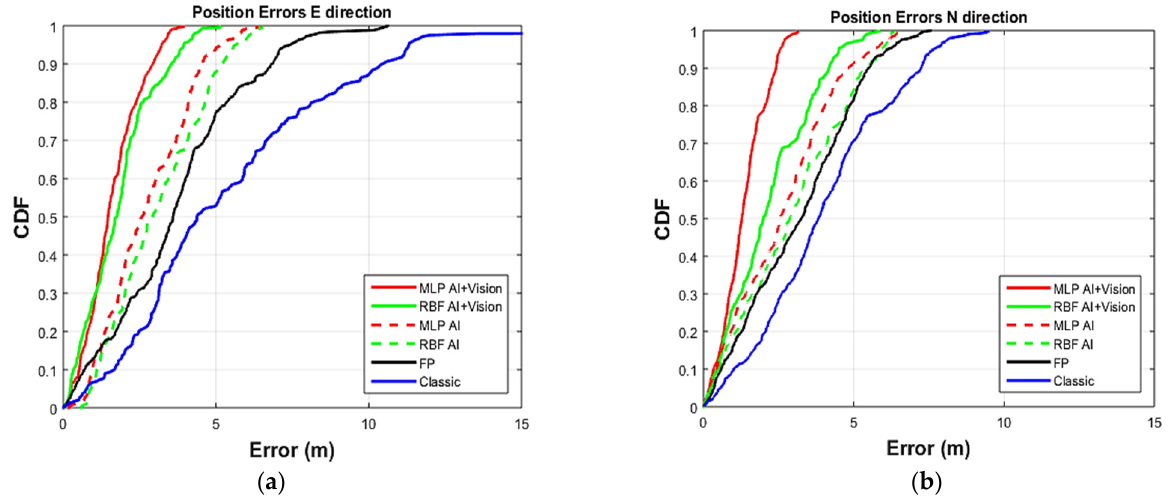
Figure 18. CDF of the positioning error for ( a ) east and ( b ) north directions. The positioning errors using uncorrected RSSI (blue line), are better than 10 m in east–west, and 7.2 m in north–south for 90% of the estimates. The fingerprinting algorithm (black line) produced results with 90% of the points better than 6.8 m in east–west and 5.5 m in